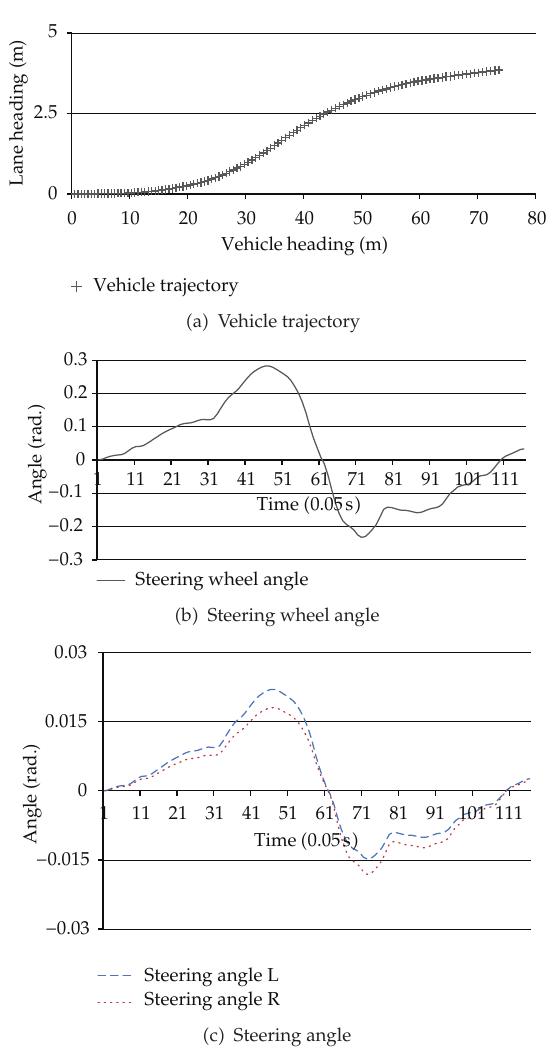
Figure 4: Variations of parameters in lane change